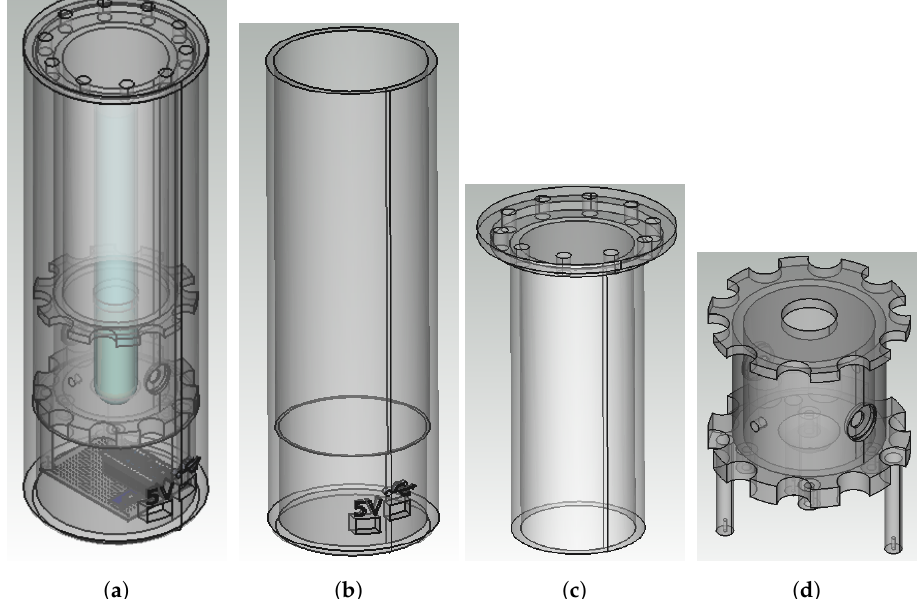
Figure 5. 3D models of the parts of the reactor: ( a ) 3D reactor, ( b ) housing, ( c ) top cover and ( d ) inner